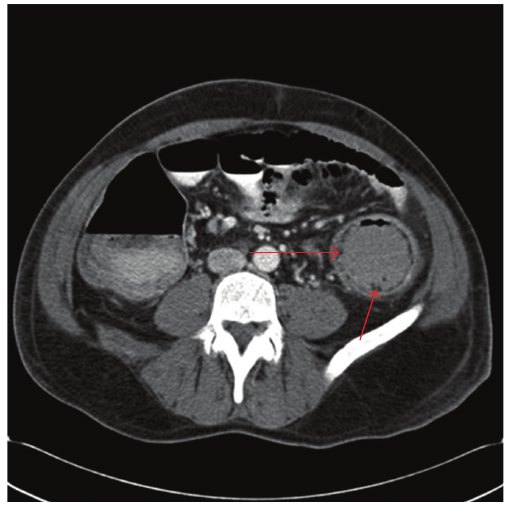
Figure 1: Abdominal computed tomography (CT) revealing sub- mucosal air-fluid cysts. Arrows demarcate submucosal gas within the wall of the left colon, pneumatosis coli.